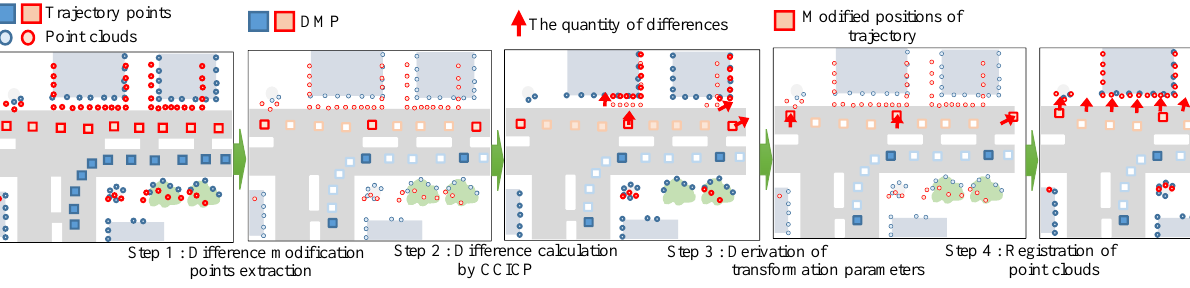
Figure 1. The overview of our method